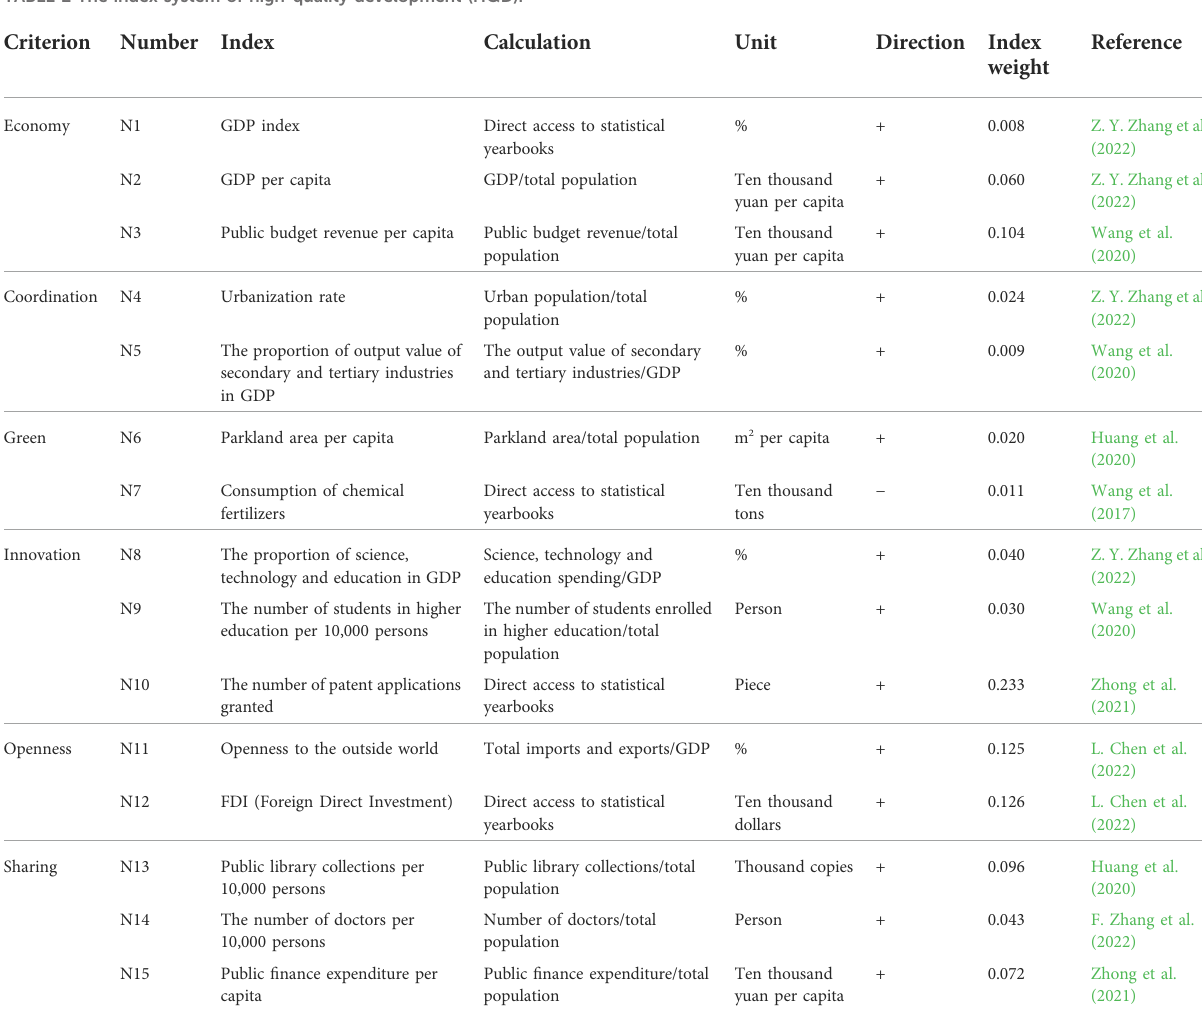
TABLE 2 The index system of high-quality development